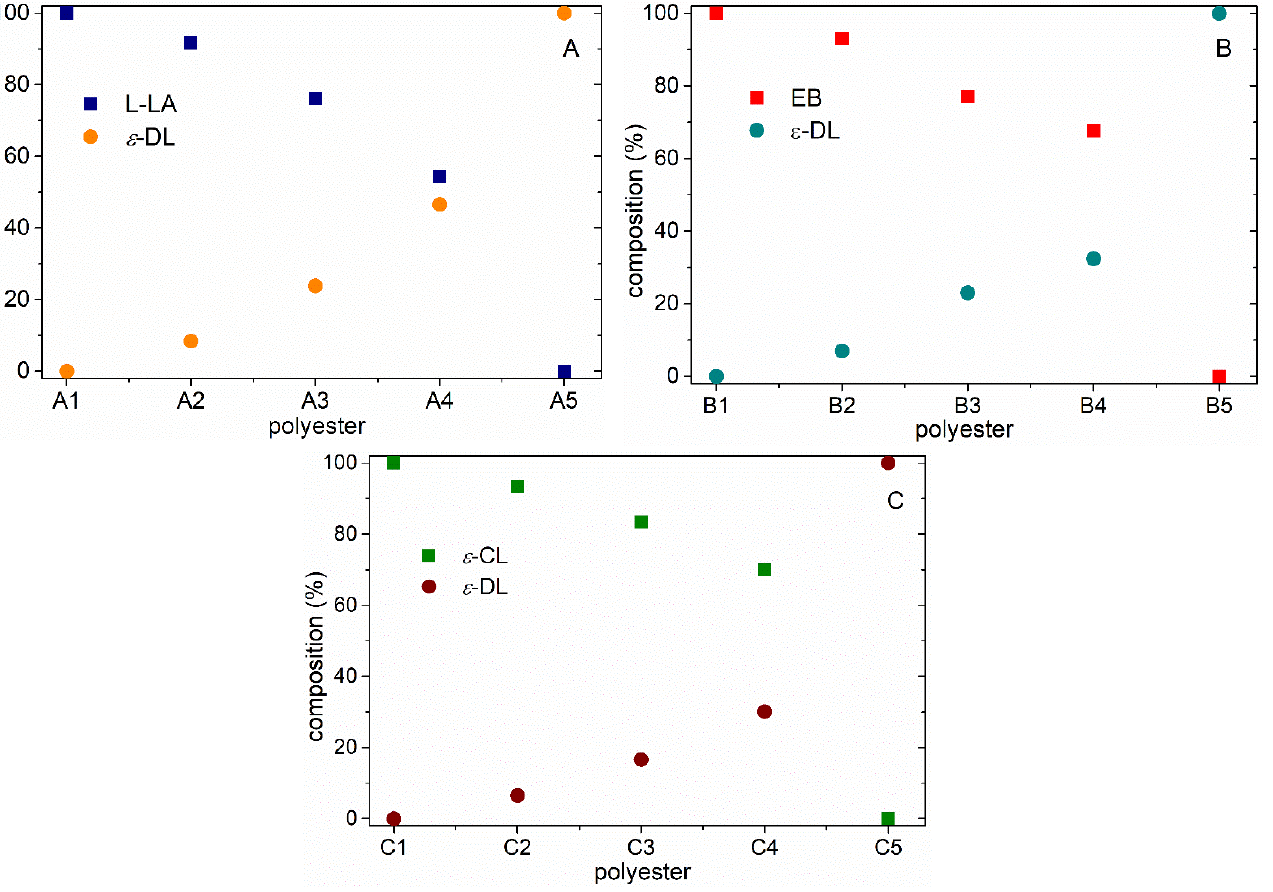
Figure 2. Percentage composition of comonomers determined through 1 H NMR in Series I ( A ), Series II ( B ) and Series III ( C ).